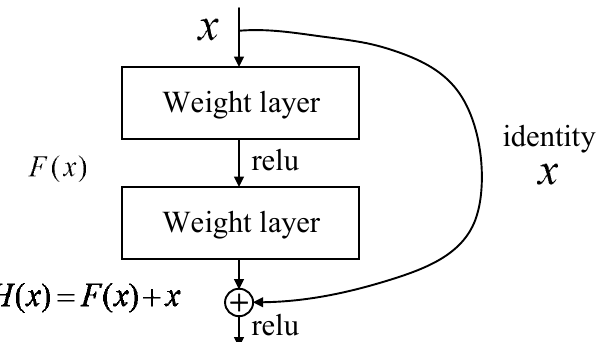
Figure 10. Residual learning module [34].